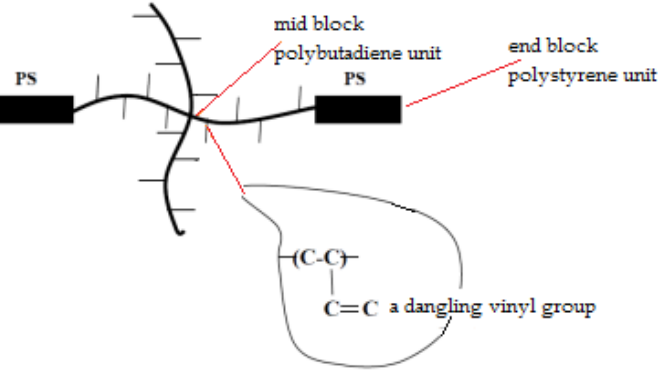
Figure 1. A two-dimensional structure of high vinyl styrene–butadiene–styrene (SBS) block copol- ymer.